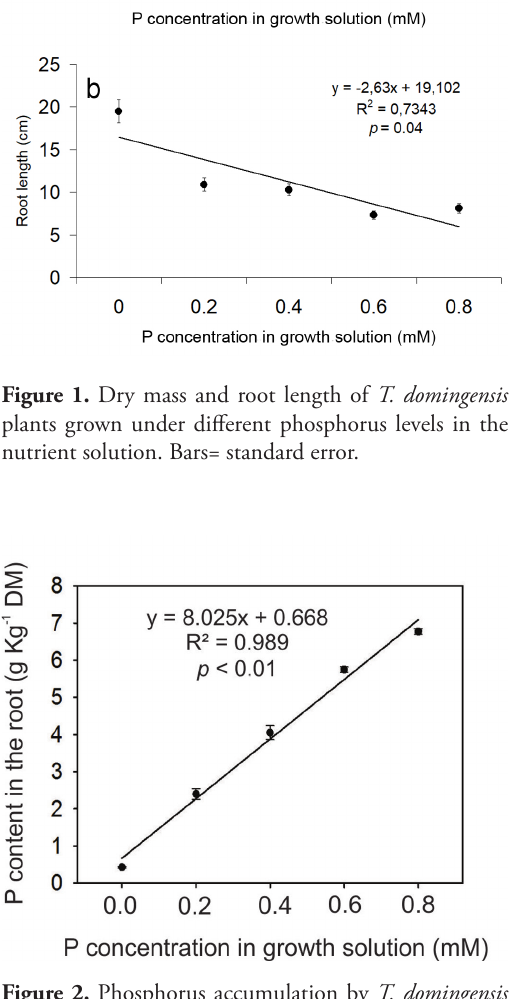
Figure 2. Phosphorus accumulation by T. domingensis roots grown under different phosphorus levels in the nutrient solution. Bars= standard error.